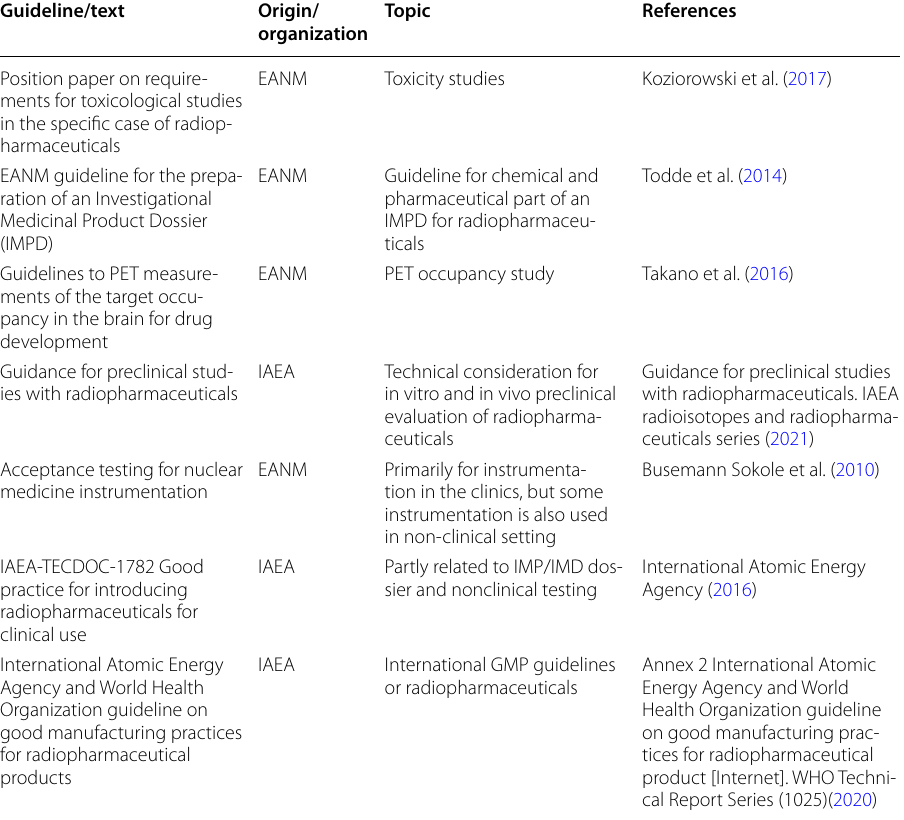
Table 3 Guideline documents on radiopharmaceuticals from professional organizations Guideline/text Origin/ organization